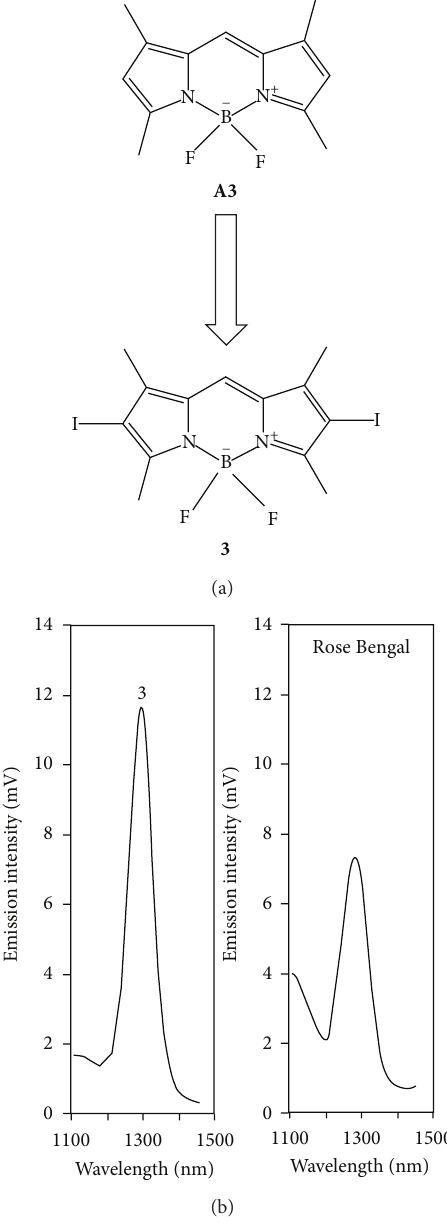
Figure 3: (a) Structures of BODIPY A3 and 3 . (b) Near-infrared singlet oxygen luminescence emission spectrum of 3 and Rose Bengalinmethanol(5 × 10 −5 M)excitedbyanArlaserlightat514 nm with 100mW output power. Reprinted with permission from [13] Copyright 2005 American Chemical